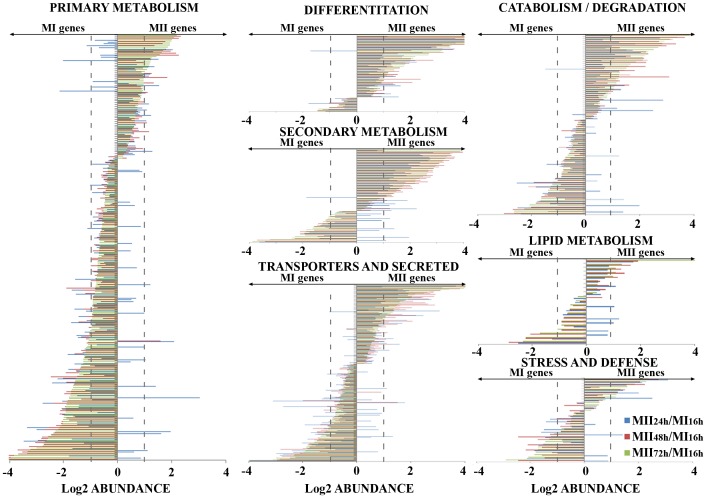
Abundance values (log2 MII/MI; averages from three biological replicates) of the genes significantly quantified (1901 in total) and grouped in functional categories.Primary metabolism (DNA/RNA replication, aerobic and anaerobic energy production, glycolysis and glyconeogenesis, pentose phosphate pathway, amino acid metabolism, nucleotide metabolism, translation, protein folding, RNA/protein processing, nucleases/RM methylases); secondary metabolism (secondary metabolites synthesis); differentiation (TTA BldA targets, Bld and Whi proteins); transporters and secreted (ABC transporters, transporters and secreted proteins); catabolism and degradation; lipid metabolism; stress and defense proteins. Dashed lines indicate the limit for considering abundance variations significant (log2 abundance ±1).